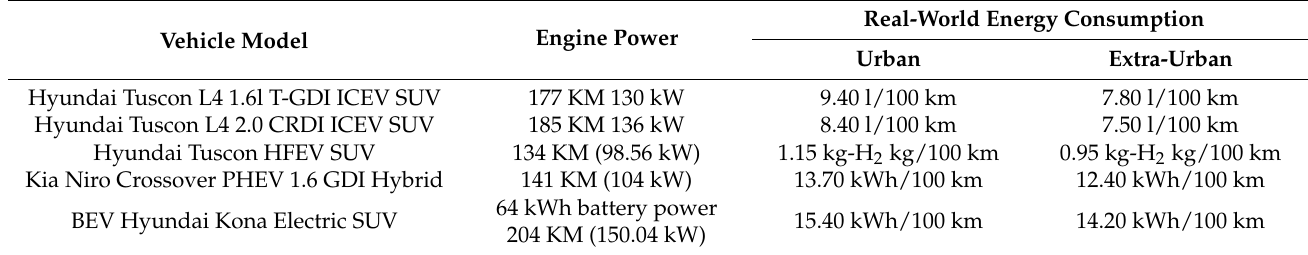
Table 1. Characteristics of selected